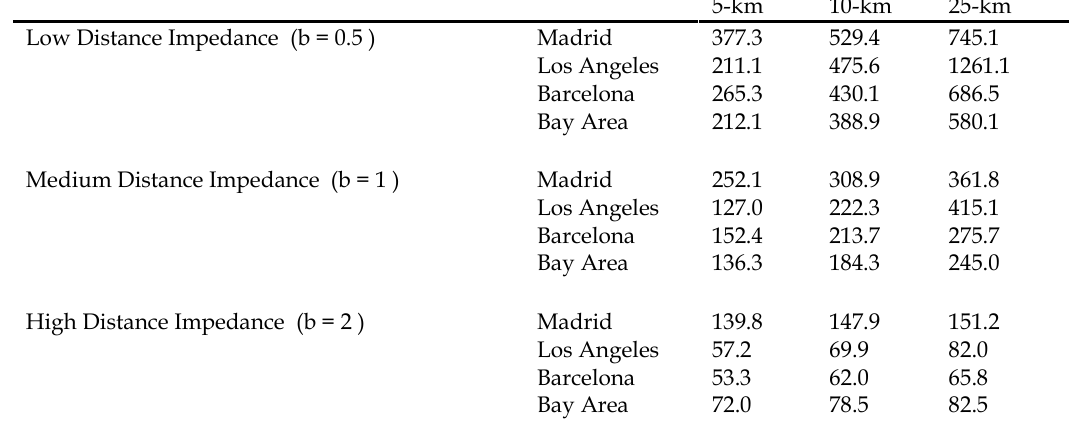
5-km 10-km 25-km